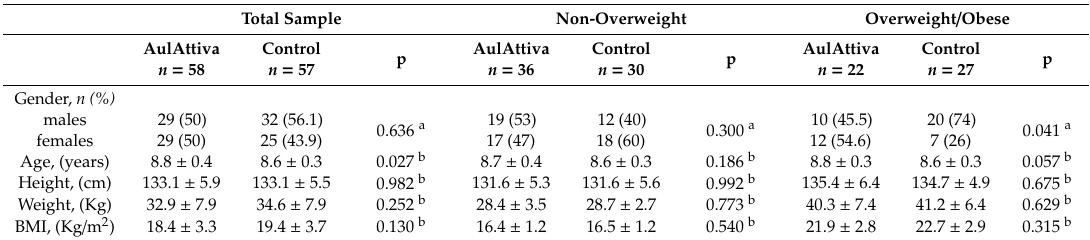
AulAttiva p n = 36 19 (53) 0.636 a 17 (47)